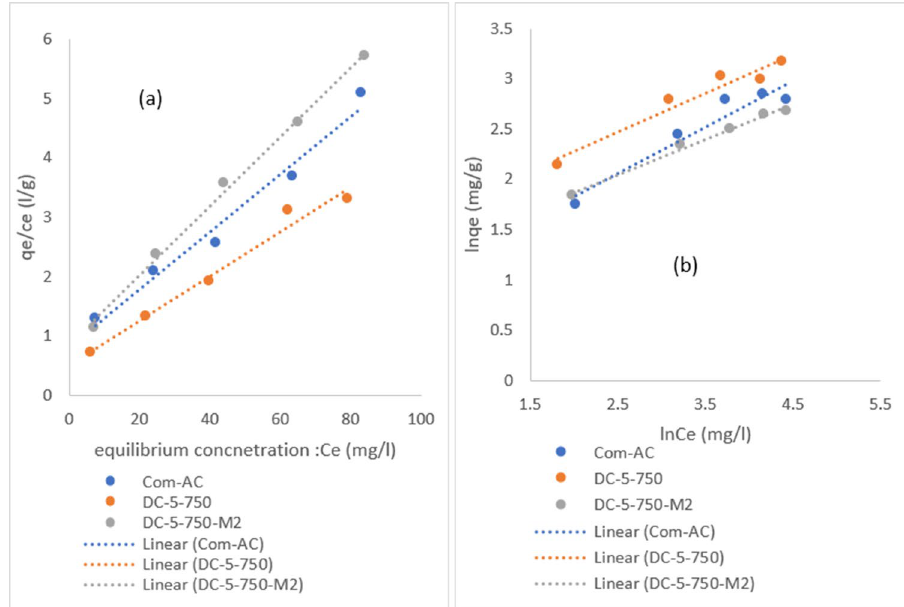
Figure 21. Langmuir ( a ) and Freundlich ( b ) isotherm plot of MR adsorption.